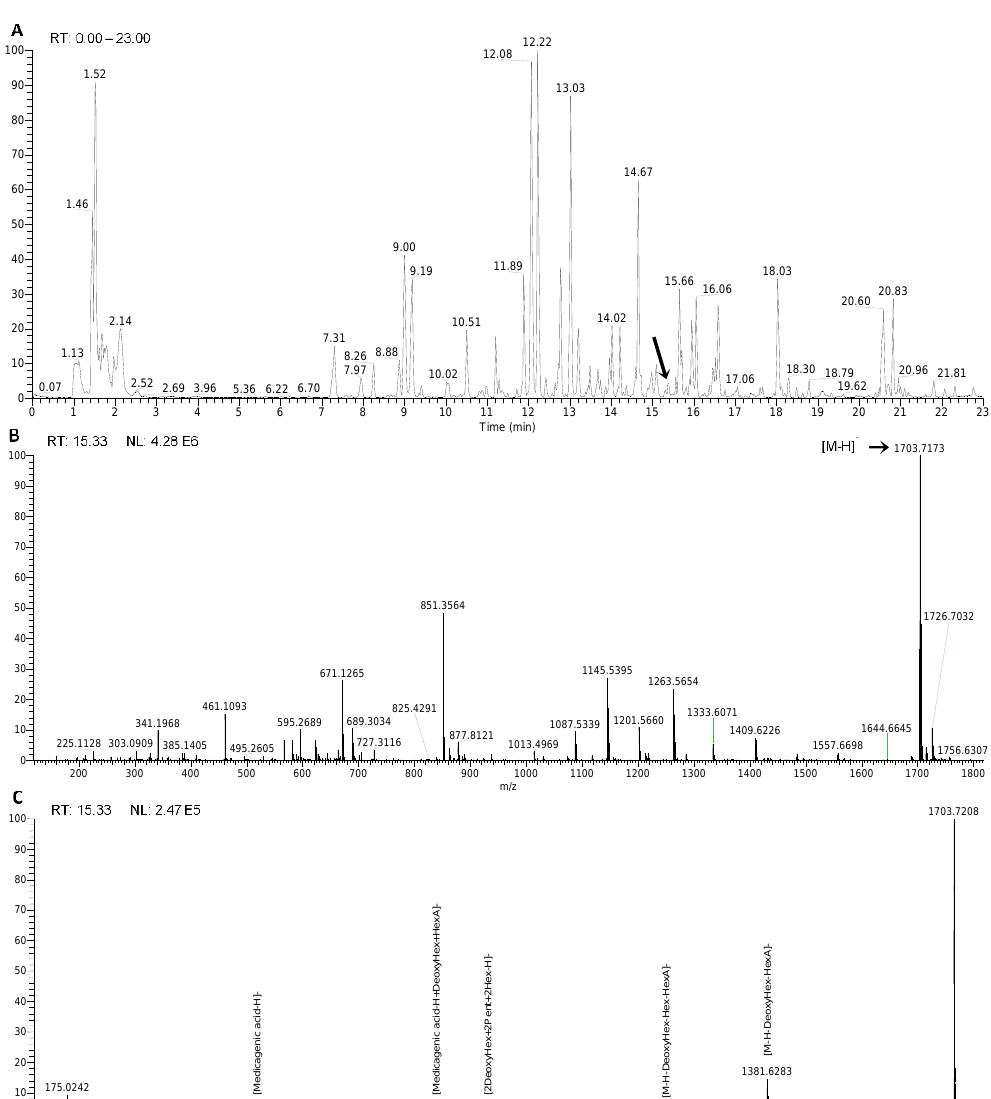
Figure 3. LC–MS data for an unknown saponin. ( A ) Chromatogram obtained for the extract of Herniaria hirsuta . ( B ) MS scan of peak at 15.33 min in the heated electrospray ionization (HESI) negative mode. ( C ) MS 2 fragmentation spectrum of the ion at m/z 1703.71734.